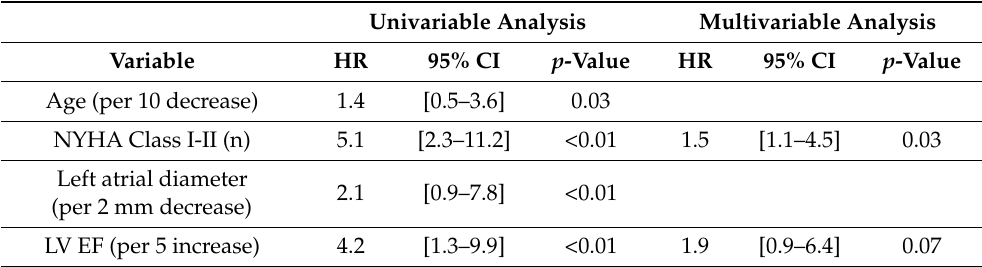
Table 3. Multivariable Predictors of response to disopyramide therapy. Univariable